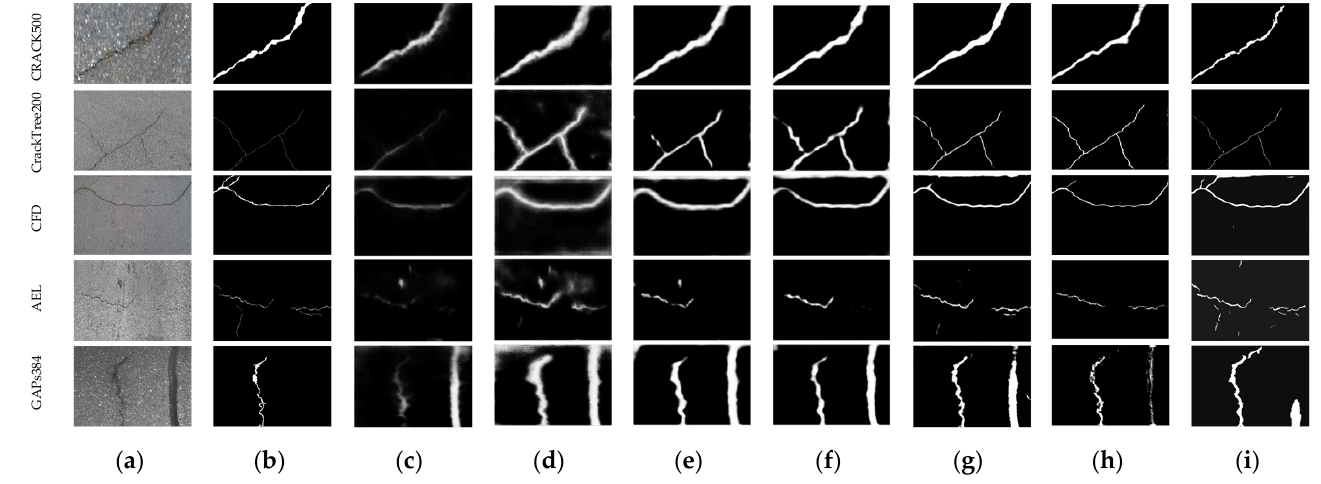
Figure 9. Subjective effect comparison results: ( a ) original images; ( b ) ground truth; ( c ) FCN[40]; ( d ) RCF [41]; ( e ) HED [11]; ( f ) FPHBN [12]; ( g ) DAUNet[18]; ( h ) SPLAC U ‐ Net [23]; ( i ) our method.